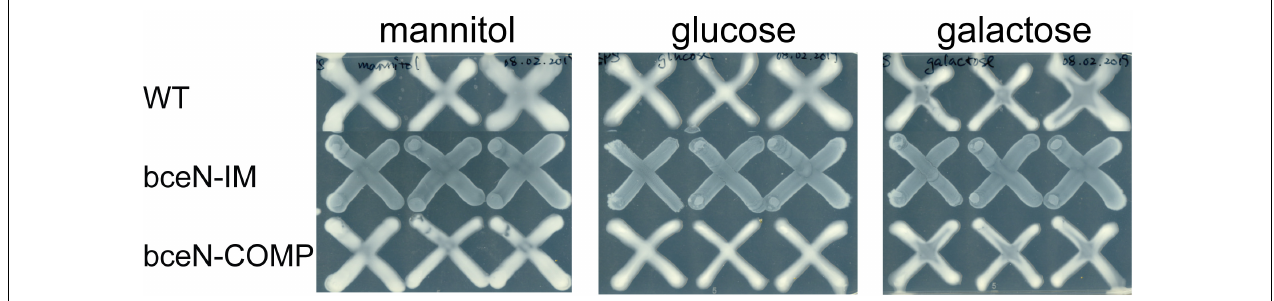
FIGURE 2 | Exopolysaccharide production of P. phymatum wild-type (WT), bceN mutant (bceN-IM), and complemented (bceN-COMP) strains assayed on plates containing 0.06% yeast extract and 1% of the indicated carbon source. Three independent biological replicates were tested per strain. Plates were incubated at 30 ◦ C for 3 days.